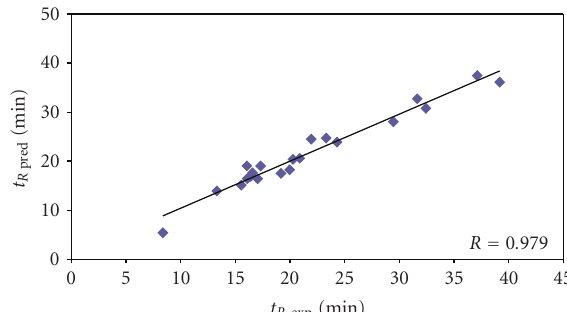
Figure 1: Correlation between experimental and predicted reten- tion times for a set of test peptides obtained from model proteins ( n =